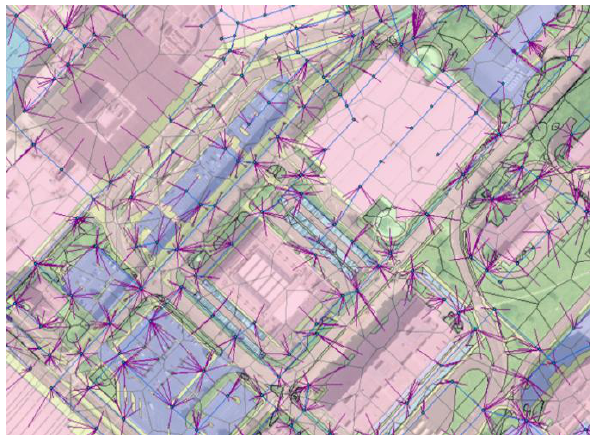
Figure 5 . Example of precise definition of all surface types for rainfall runoff